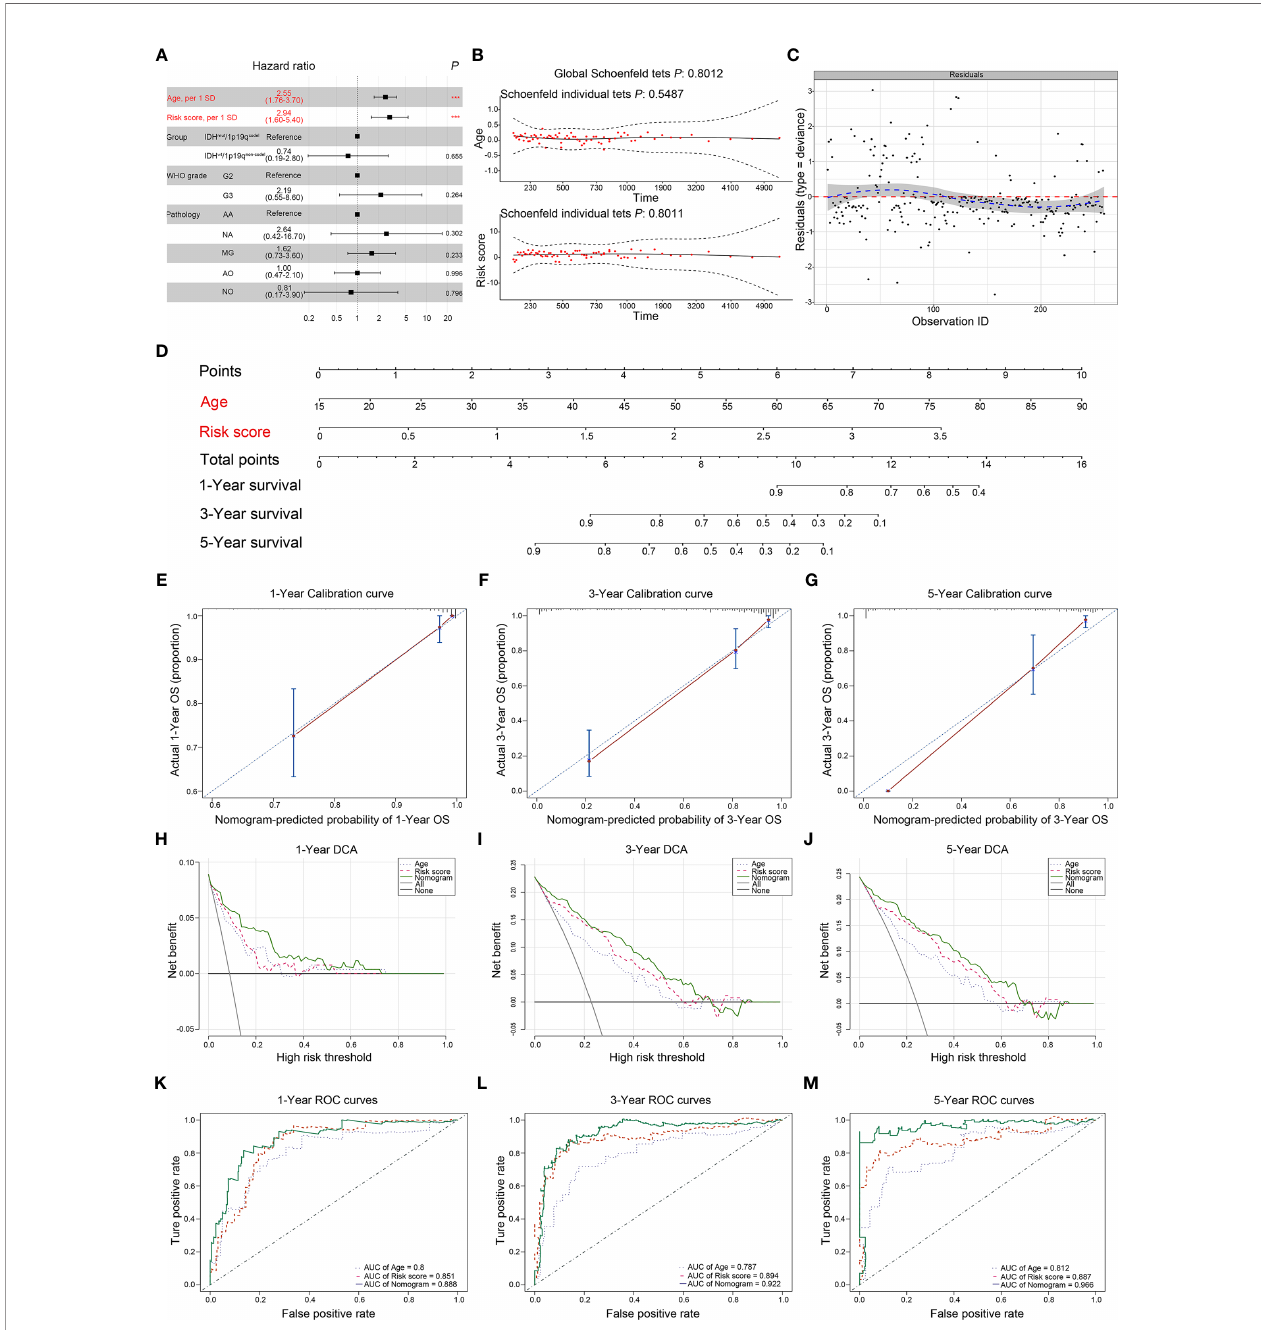
FIGURE 8 | Establishment and assessment of the comprehensive nomogram in TCGA dataset. (A) Univariate and multivariate analyses of the transcriptional risk score, clinical factors, and pathological subtypes with OS. The statistical signi fi cance level was indicated by different colors; red indicated statistical signi fi cance, and black indicated no signi fi cance. (B) The Schoenfeld residual suggested that this model met the PH. The Schoenfeld model residuals of age and transcriptional risk score were plotted to obtain a preliminary assessment in which these predictive indicators should be enrolled in the nomogram. (C) The Deviance residuals test indicated that there were no outliers. (D) Comprehensive nomogram including age and transcriptional risk score was established to predict 1-, 3-, and 5-year OS probability in LGGs. (E – G) The calibration curves of 1, 3, and 5 years showed more appropriate calibration ability in TCGA cohort, in which the blue dotted lines represented the ideal predictive model, and the red solid line represented the nomogram model. (H – J) The DCA curves showed a comparable net bene fi t if the threshold probability for a patient or a doctor was within a range from 0 to 0.80 during 1, 3, and 5 years. The y -axis represented the net bene fi t. The x -axis represented the predicted OS probability. The oblique smooth solid line represented a type of hypothesis in which all patients survive at a corresponding time. The horizontal smooth solid line represented a type of hypothesis in which none of the patients survive for more than 1 year. (K – M) The time-dependent ROC curve analysis for the nomogram and single indicator during 1, 3, and 5 years in TCGA cohort, respectively. ***P <